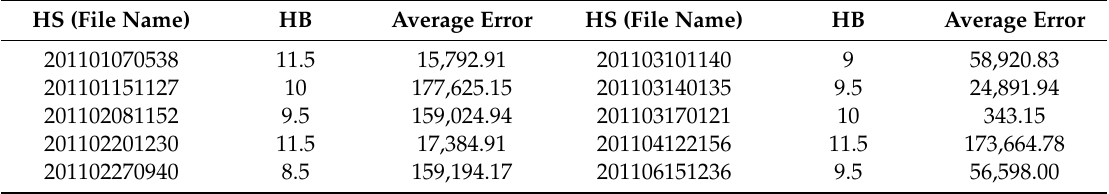
Table 4. Results of segmentation for dataset A. (HB: heartbeat).